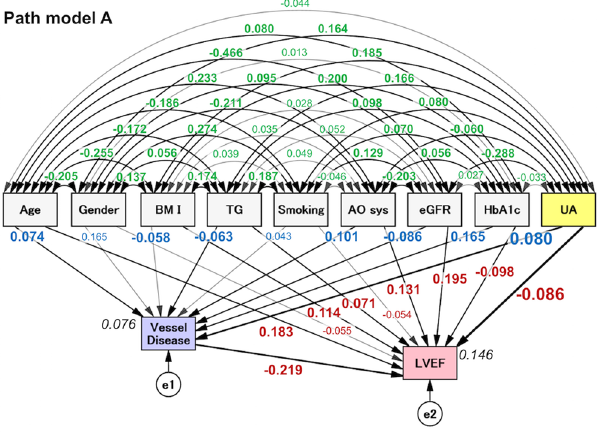
Figure 1. The path model [A]: An explanatory drawing of the possible cascade from risk factors to the number of diseased vessels and LVEF. This path has a coefficient showing the standardized coefficient of a regressing independent variable on a dependent variable of the relevant path. These variables indicate standardized regression coefficients (direct effect) [bold typeface indicates remarkable values], squared multiple correlations [narrow italics] and correlations among exogenous variables [green]. BMI, body mass index; TG, triglyceride; AOsys, systolic blood pressure; eGFR, estimated glomerular filtration rate; HbA1c, hemoglobin A1c; UA, uric acid; e, extraneous variable.